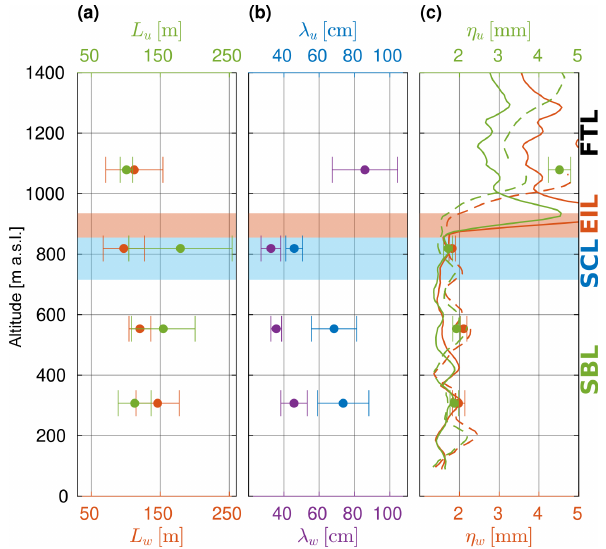
Figure 19. Turbulent length scales in the coupled STBL (flight no. 5): (a) integral scale L , (b) Taylor microscale λ , (c) Kolmogorov scale η . Subscripts u and w denote horizontal and vertical velocity components, respectively. Some of the results for LEG1079 in the FT are out of the range presented.